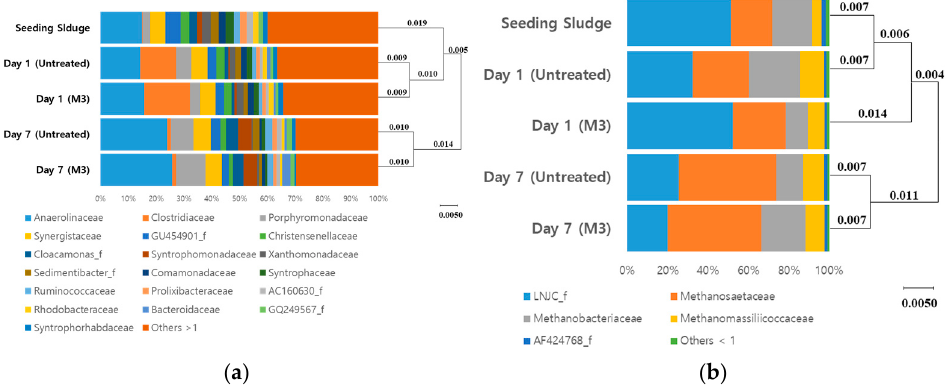
Figure 3. Microbial community structure of ( a ) bacteria and ( b ) Achaea during methane production from ball-mill treated and untreated food wastes. Operational Taxonomic Units (OTUs) were classified at the species level (97% sequence similarity). The data shown were binned at the family level.